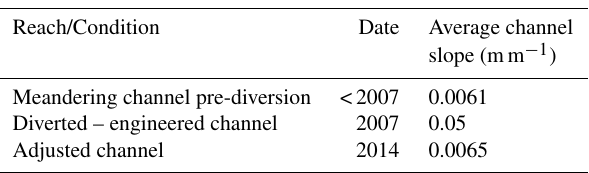
Table 5. Changes in reach averaged slopes before and after channel